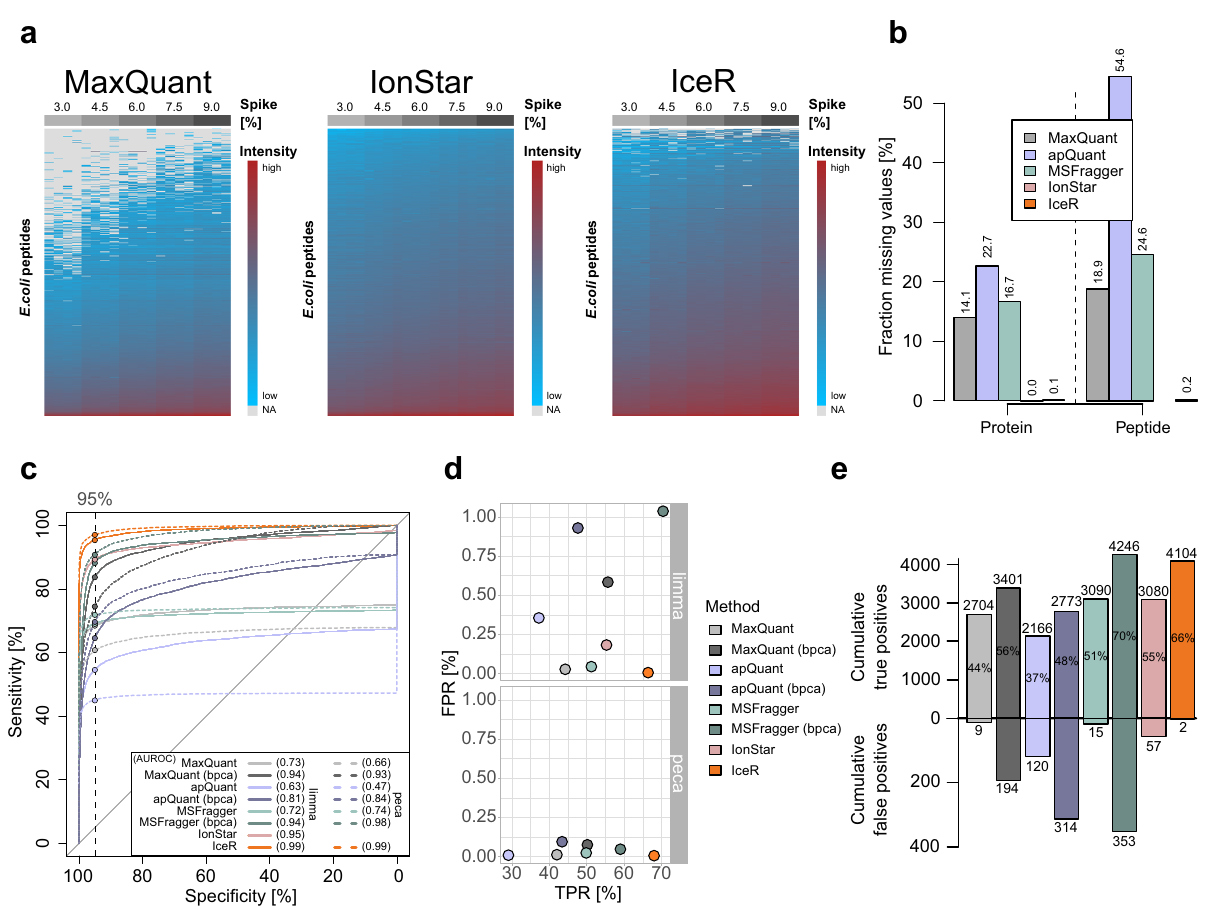
Fig. 2 IceR outperforms other label-free quanti fi cation work fl ows. a Heatmap representation of quanti fi ed peptides of spiked E. coli lysate at fi ve spike amounts into constant background (n = 4) in MaxQuant (left), IonStar (middle) and IceR (right) results. Low abundance peptides are coloured blue, high abundance peptides are coloured red, and missing values are indicated in grey. b Fraction of missing values on protein- and peptide-level in MaxQuant (grey), apQuant (purple), MSFragger (green), IonStar (pink), and IceR (orange) results. c Receiver operating characteristics (ROC) over all pairwise differential expression analyses for MaxQuant (light grey), MaxQuant with bpca imputation (dark grey), apQuant (purple), apQuant with bpca imputation (dark purple), MSFragger (green), MSFragger with bpca imputation (dark green), IonStar (pink) and IceR (orange) on protein-level using limma (solid line) and peptide-level using peca (dashed line). Area under the ROC (AUROC) per condition is indicated. Dashed vertical line and respective dots represent observed sensitivity at 95 % speci fi city per method. d True and false positive rates over all (10) pairwise DE analyses using limma or peca for MaxQuant (grey), MaxQuant with imputation (dark grey), apQuant (purple), apQuant with bpca imputation (dark purple), MSFragger (green), MSFragger with bpca imputation (dark green), IonStar (pink), and IceR (orange). e Cumulative true and false positives over all (10) pairwise DE analyses for MaxQuant (grey), MaxQuant with bpca imputation (dark grey), apQuant (purple), apQuant with bpca imputation (dark purple), MSFragger (green), MSFragger with bpca imputation (dark green), IonStar (pink), and IceR (orange) when using limma. True positive rates are indicated. bpca – Bayesian principal component